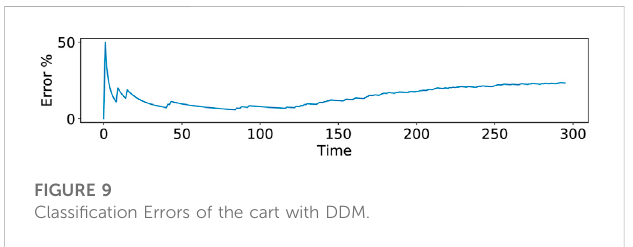
FIGURE 9 Classi fi cation Errors of the cart with DDM.